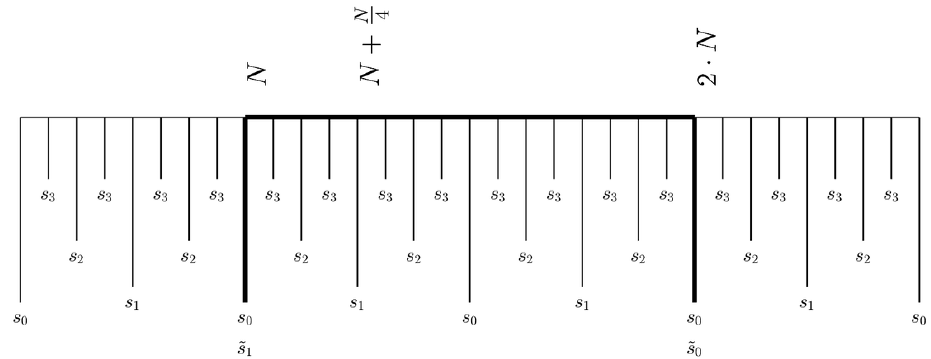
Figure 5. Bits boundaries from position N /2 to 2 N + N /2 in the 4 N extended